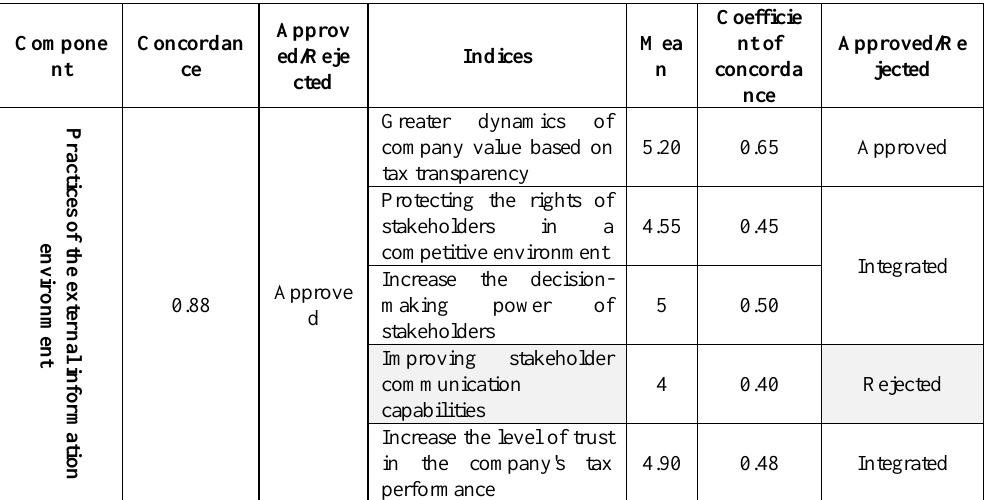
Table 4. Analysis of the meta-synthesis results in first-round